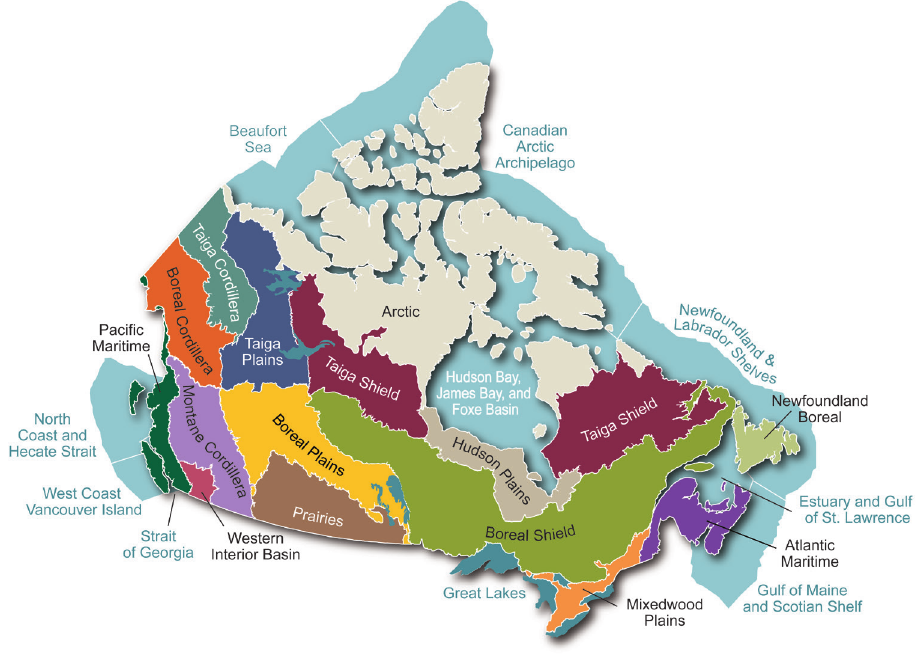
Figure 1. Terrestrial ecozones of Canada as included in the Canadian Biodiversity Ecosystem Status and Trends 2010 report (Federal, Provincial, and Territorial Governments of Canada 2010). [Reprinted with permission from Environment and Climate Change